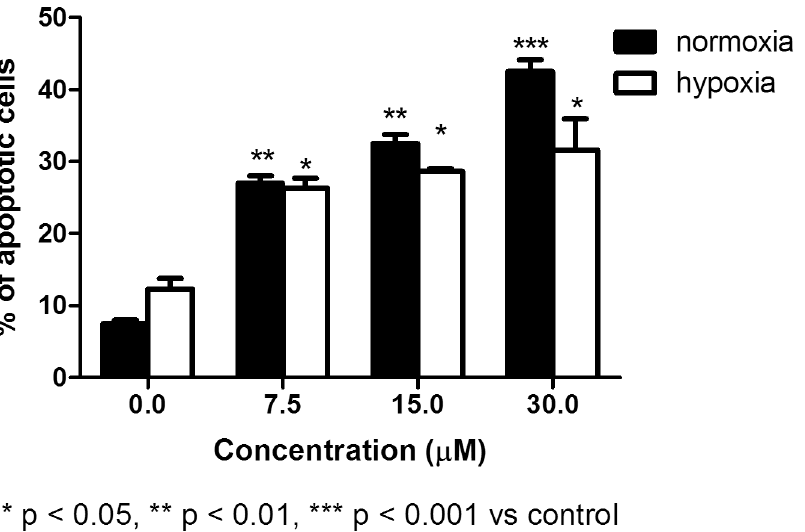
Figure 4. Induction of apoptosis by SR in normoxic and hypoxic conditions on REH cells. Cells were treated with 0 to 30 m M SR for 24 h. The % of apoptotic cells recorded in the untreated cultures was subtracted from that observed in cultures treated with SR. Data are presented as mean 6 SEM of at least four different experiments.